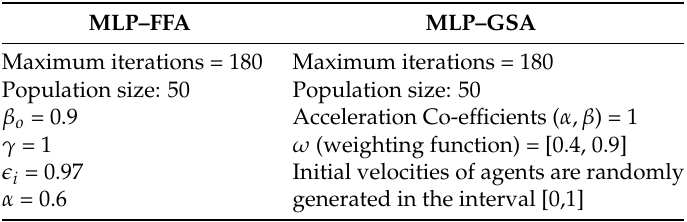
Table 3. Parameter settings of FFA and